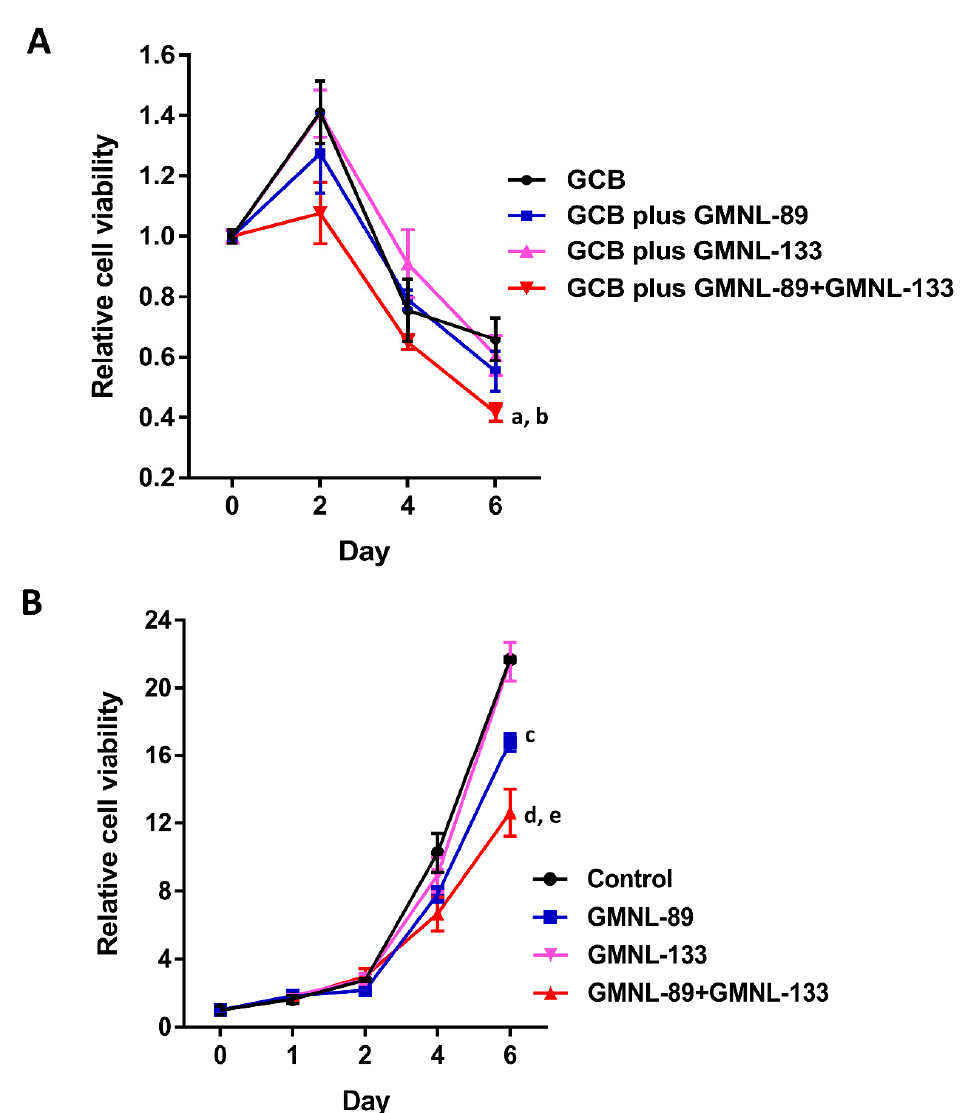
Figure 8. The relative cell viability of BXPC-3 pancreatic cancer cells in di ff erent probiotic lysate treatment (25 µ g / mL) at di ff erent time points was measured by the MTT assay (OD570nm). The value of relative cell viability represents the fold change compared to baseline (Day 0) of untreated cell numbers. ( A ) In the presence of standard chemotherapeutic agent GCB a P < 0.001 di ff erences between GCB and GCB with GMNL-89 + GMNL-133. b P < 0.01 di ff erences between GCB and GCB with GMNL-89. ( B ) In the absence of GCB c P < 0.001 di ff erences between control and GMNL-89. d P < 0.001 di ff erences between control and GMNL-89 + GMNL-133. e P < 0.01 di ff erences between GMNL-89 and GMNL-89 + GMNL-133. GCB, gemcitabine.